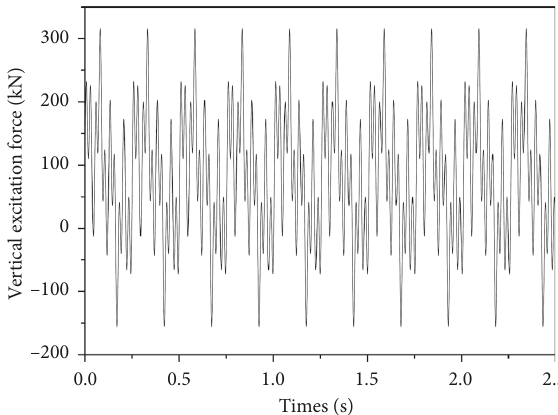
Figure 5: Oscillogram of the simulated vertical excitation